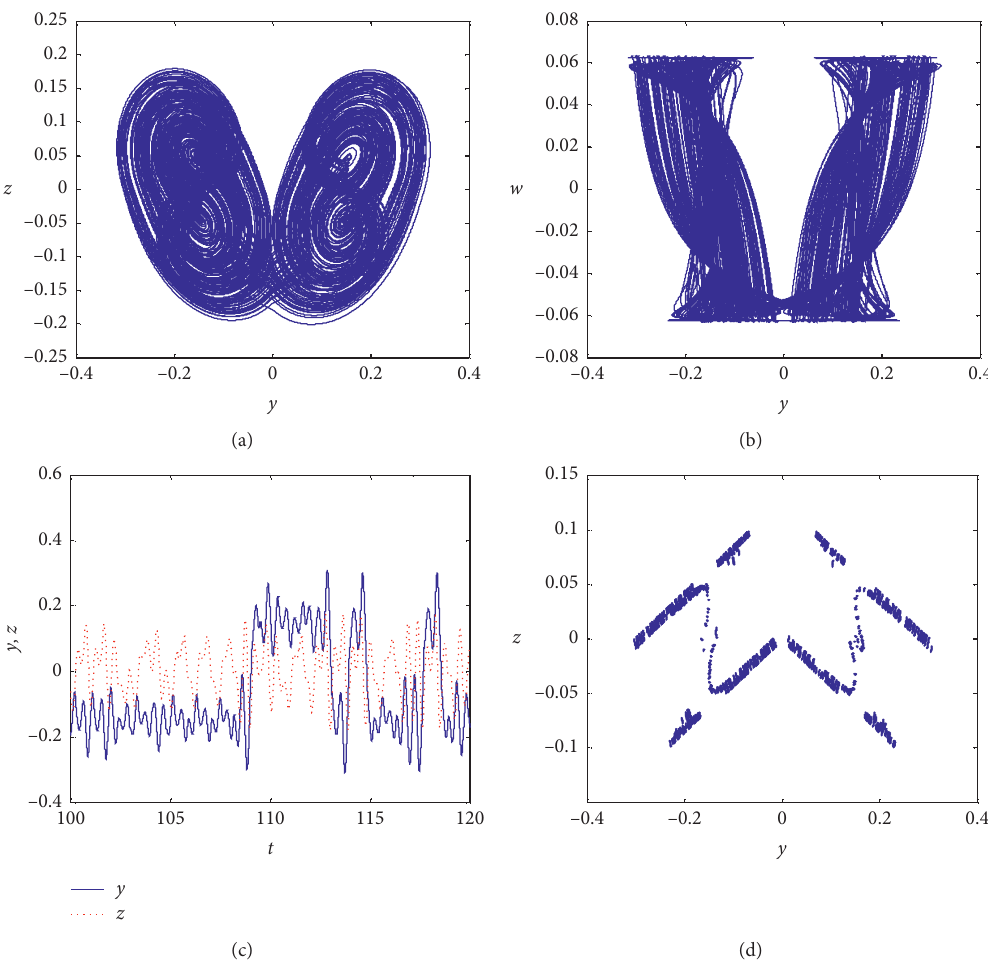
Figure 2: Numerical simulations for the proposed multiscroll chaotic system under mode 2: M ( − , +). (a) y versus z , (b) y versus w , (c) t versus y and t versus z , and (d) Poincar´e map in y versus z under x � y .